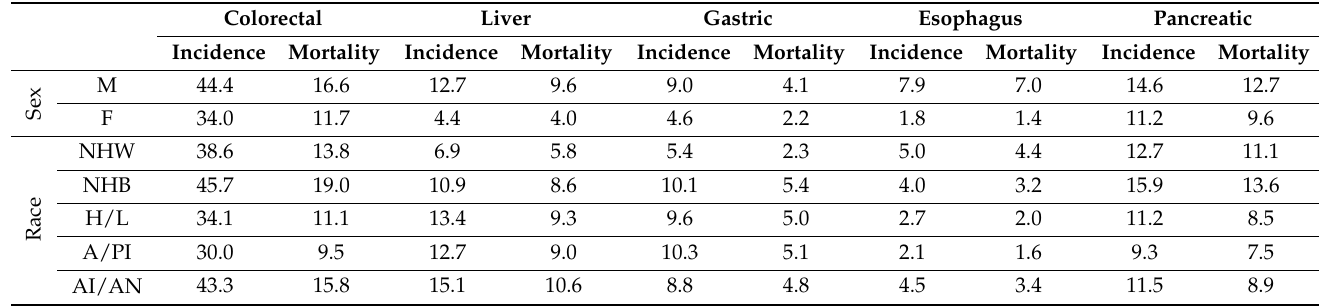
Table 1. Health disparities in gastrointestinal